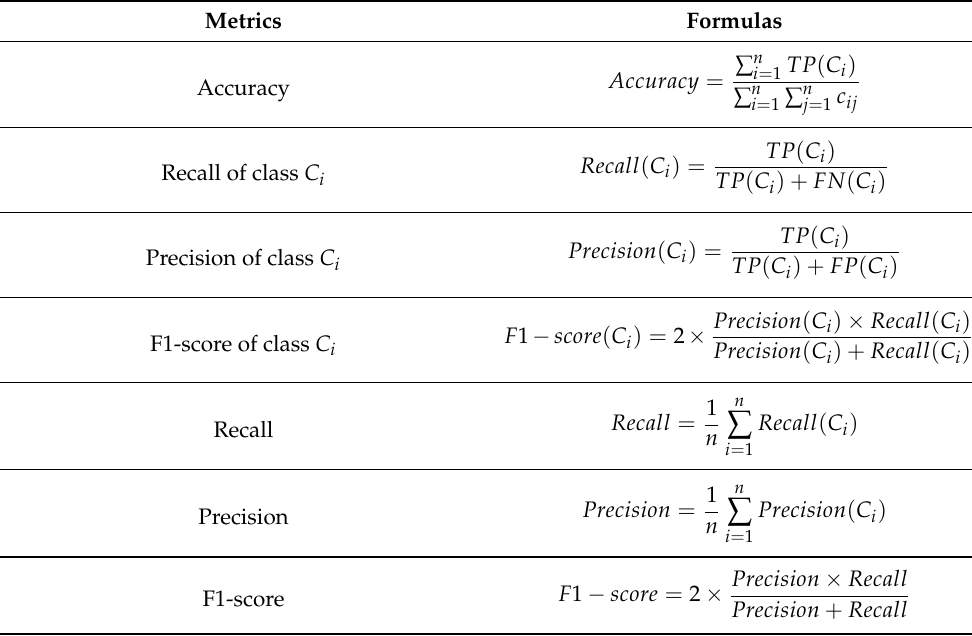
Table 3. Performance metrics for a multiclass confusion